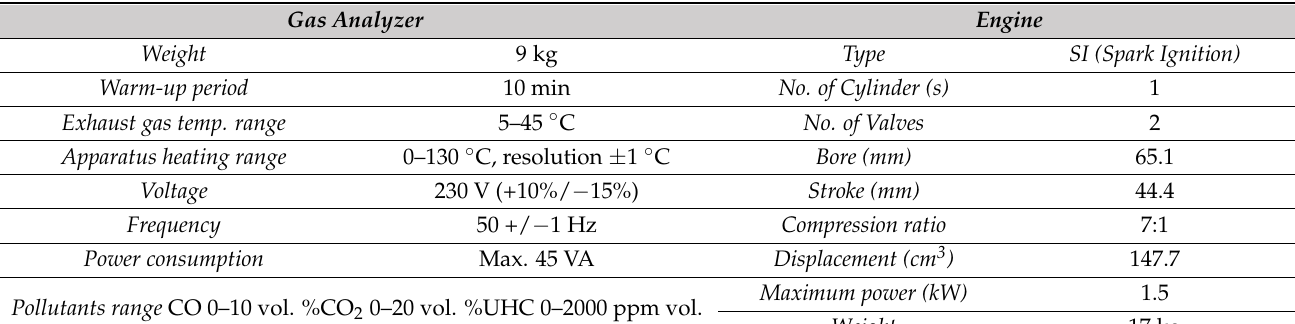
Table 1. Gas analyzer and engine